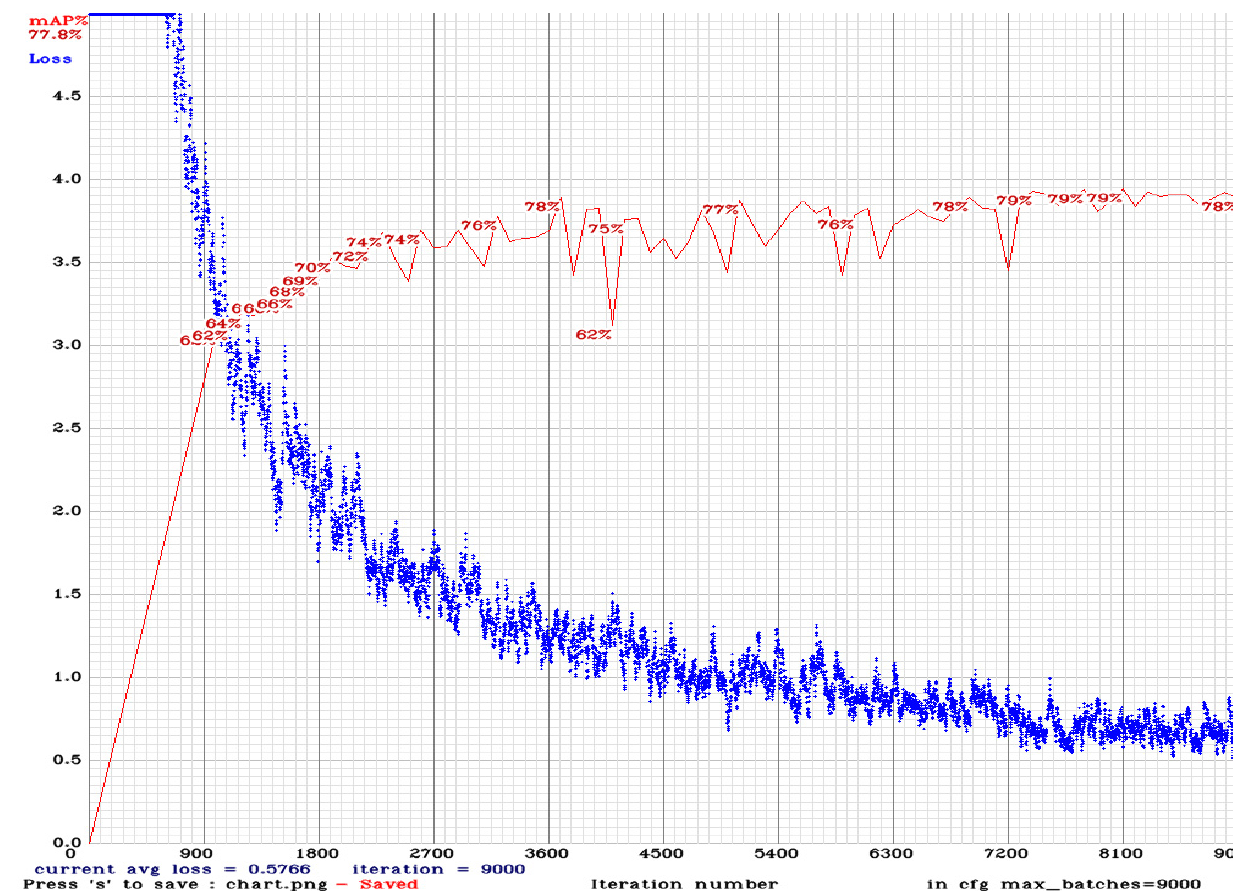
Figure 6. Training performance using Yolo V4 CSP SPP.